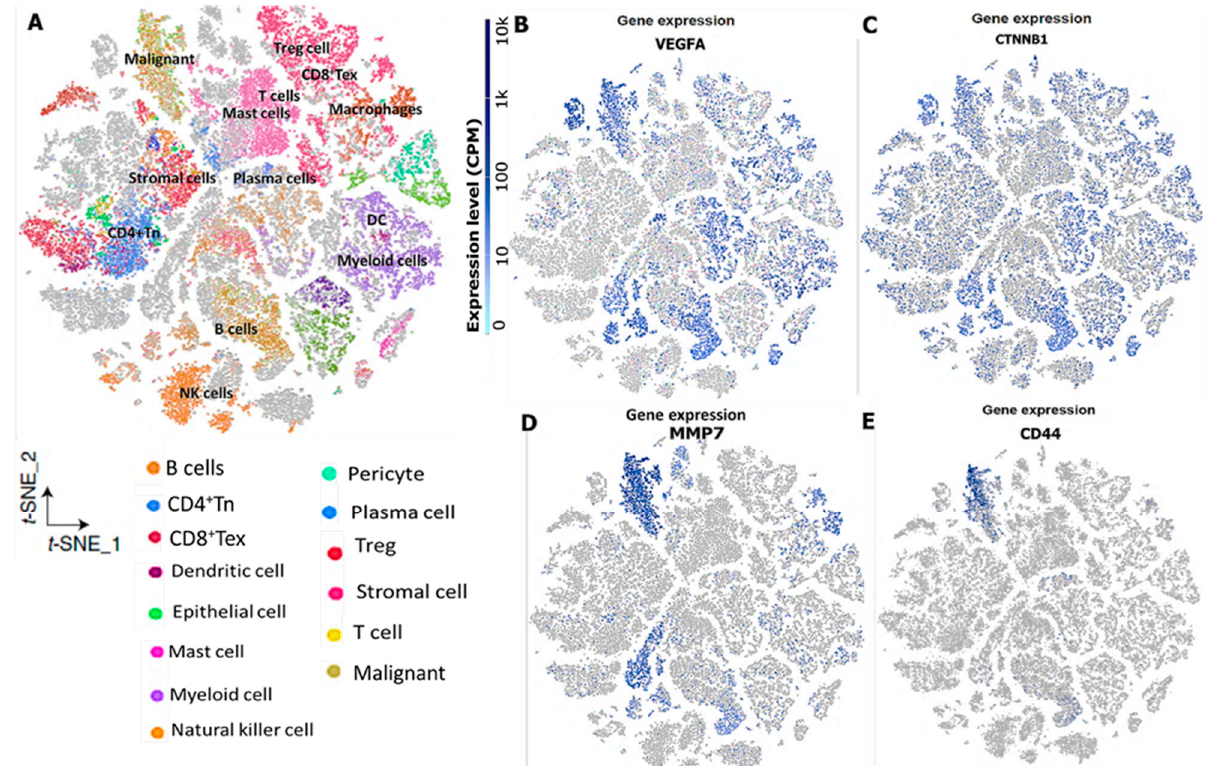
Figure 9. Single cell sequencing profiling of VEGFA/CTNNB1/MMP7/CD44 in the tumor microenvi- ronment of primary CRC. ( A ) T-distributed stochastic neighbor embedding (t-SNE) plot of single-cell RNA-seq data from M-E-MAT-8410 and (9 patients; GSE144735) CRC tumors. Proportions of the immune cell types in CRC tissue and normal colon tissue on average (left). ( B – E ) The expression distribution of VEGFA/CTNNB1/MMP7/CD44 in different cell types, including regulatory T cells, mast cells, macrophages, myeloid cells; low expression level of CD4 + Tc and CD8 + Tc cells; and exhausted CD8 T cells with the TME of CRC